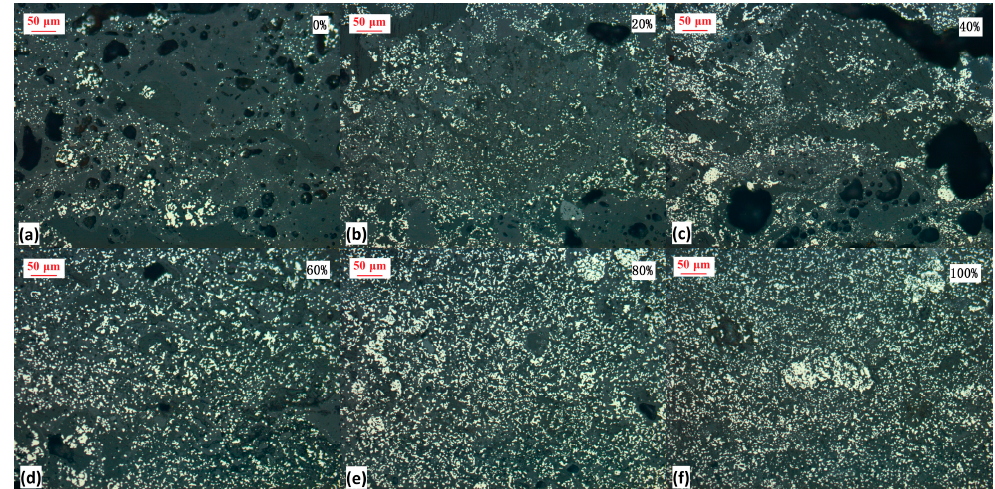
HM ore ratio (wt. %) Figure 7. Effect of ratio of high-manganese iron ore (HM ore) in blend on metallization degree of reduced pellets (reducing at 1050 °C with C/Fe mass ratio of 1.5).